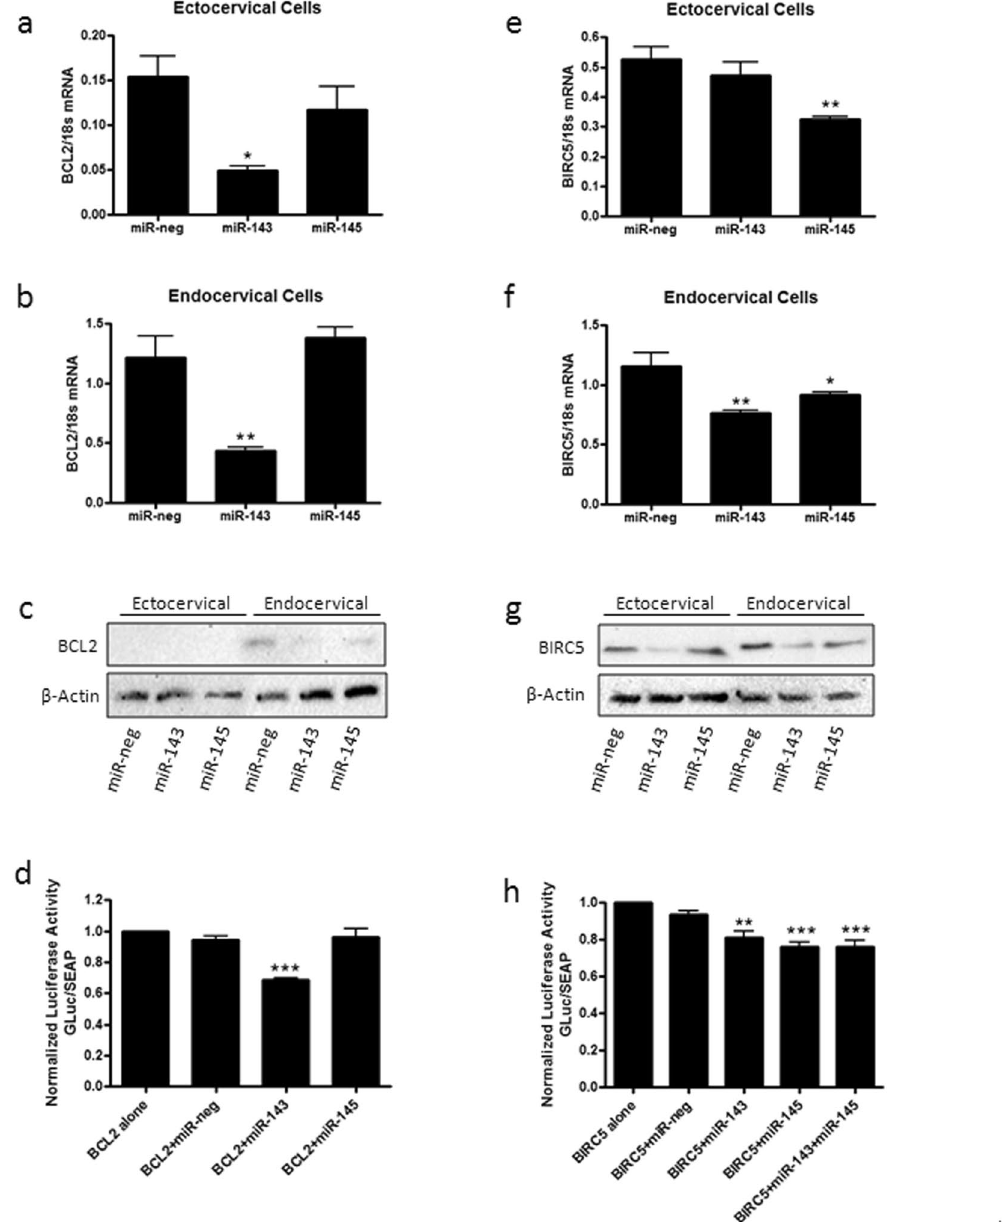
Figure 6. miR-143 and miR-145 repressed apoptosis gene expression. Ectocervical and endocervical cells were transfected with miR-negative control (miR-neg), miR-143 or miR-145 and expression of downstream target genes were measured by QPCR and western blot. BCL2, a negative regulator of apoptosis and a predicted target of miR-143, was significantly decreased with miR-143 but not miR-145 overexpression in ectocervical ( a ) and endocervical cells ( b ). Protein expression of BCL2 was reduced by miR-143 in transfected endocervical cells while BCL2 protein was too low to be detectable in ectocervical cells ( c ). 3 ′ UTR luciferase assays in HEK293T cells confirmed that BCL2 is a direct target of miR-143 ( d ). BIRC5, a predicted target of miR-143 and miR- 145, was significantly repressed by miR-145 in ectocervical ( e ) cells and by both miR-143 and miR-145 in endocervical cells ( f ). BIRC5 protein expression was reduced by miR-143 and miR-145 in endocervical cells while BIRC5 protein levels were decreased by miR-143 and unchanged by miR-145 in ectocervical cells ( g ). 3 ′ UTR luciferase assays verified that BIRC5 is a target of miR-143 and miR-145 ( h ). 3 ′ UTR assay results are expressed as a ratio of Gaussia Luciferase (GLuc) activity over Secreted Alkaline Phosphatase (SEAP) which has been normalized to cells transfected with the plasmid alone. Values are mean ± SEM. * p < 0.05, ** p < 0.01, *** p <